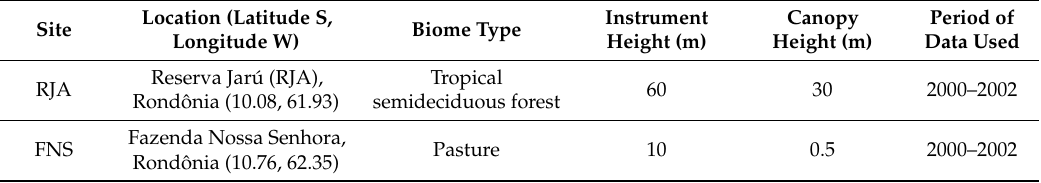
Table 1. Summary of the characteristics of the flux tower sites in the analysis.